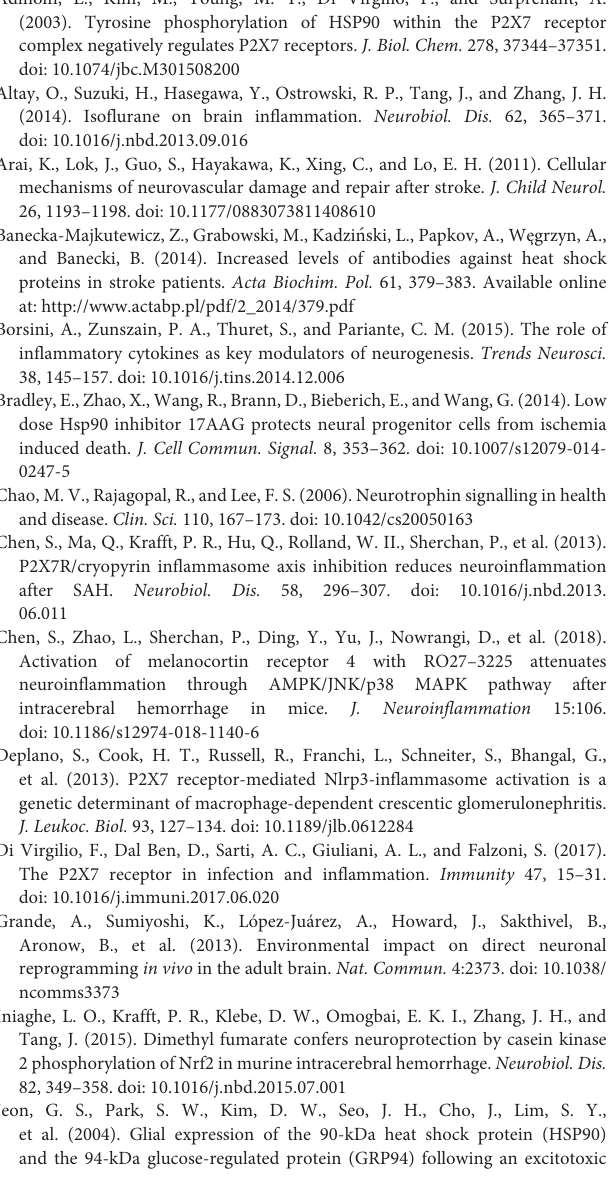
FIGURE S3 | Effects of 17-AAG in the pathway in sham condition. (A) Representative western blots. (B–H) Quantitative analyses of P2X7R, NLRP3, ASC, caspase-1, IL-1 β , BDNF and DCX in the left hemisphere in the sham condition; the expression of P2X7R, NLRP3, ASC, caspase-1, IL-1 β , BDNF and DCX show no significant difference among sham, sham + vehicle and sham + 17-AAG group. n = 6 per group; n.s, no significant. FIGURE S4 | DCX positive cells count in the left hemisphere in the Experiments 3 and 4. (A) DCX positive cells count in the Experiment 3; n = 4 per group. ∗ P < 0.05 vs. sham; # P < 0.05 vs. SAH + vehicle; $ P < 0.05 vs. SAH + 17-AAG + vehicle. The error bars represent SD. (B) DCX positive cells count in the Experiment 4; n = 4 per group. ∗ P < 0.05 vs. sham; # P < 0.05 vs. SAH + vehicle; & P < 0.05 vs. SAH + 17-AAG + vehicle; $ P < 0.05 vs. SAH + rHSP90 +